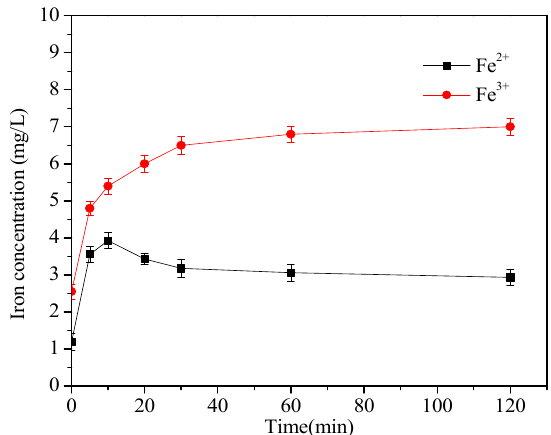
Figure 11. Concentration of Fe 2+ and Fe 3+ in the nZVI/2BC-PS system. [DTZ] = 20 mg L − 1 ; [nZVI/2BC] = 0.45 g L − 1 ; [PS] = 25.0 mM; Temp= 25 °C; pH = 7.0.